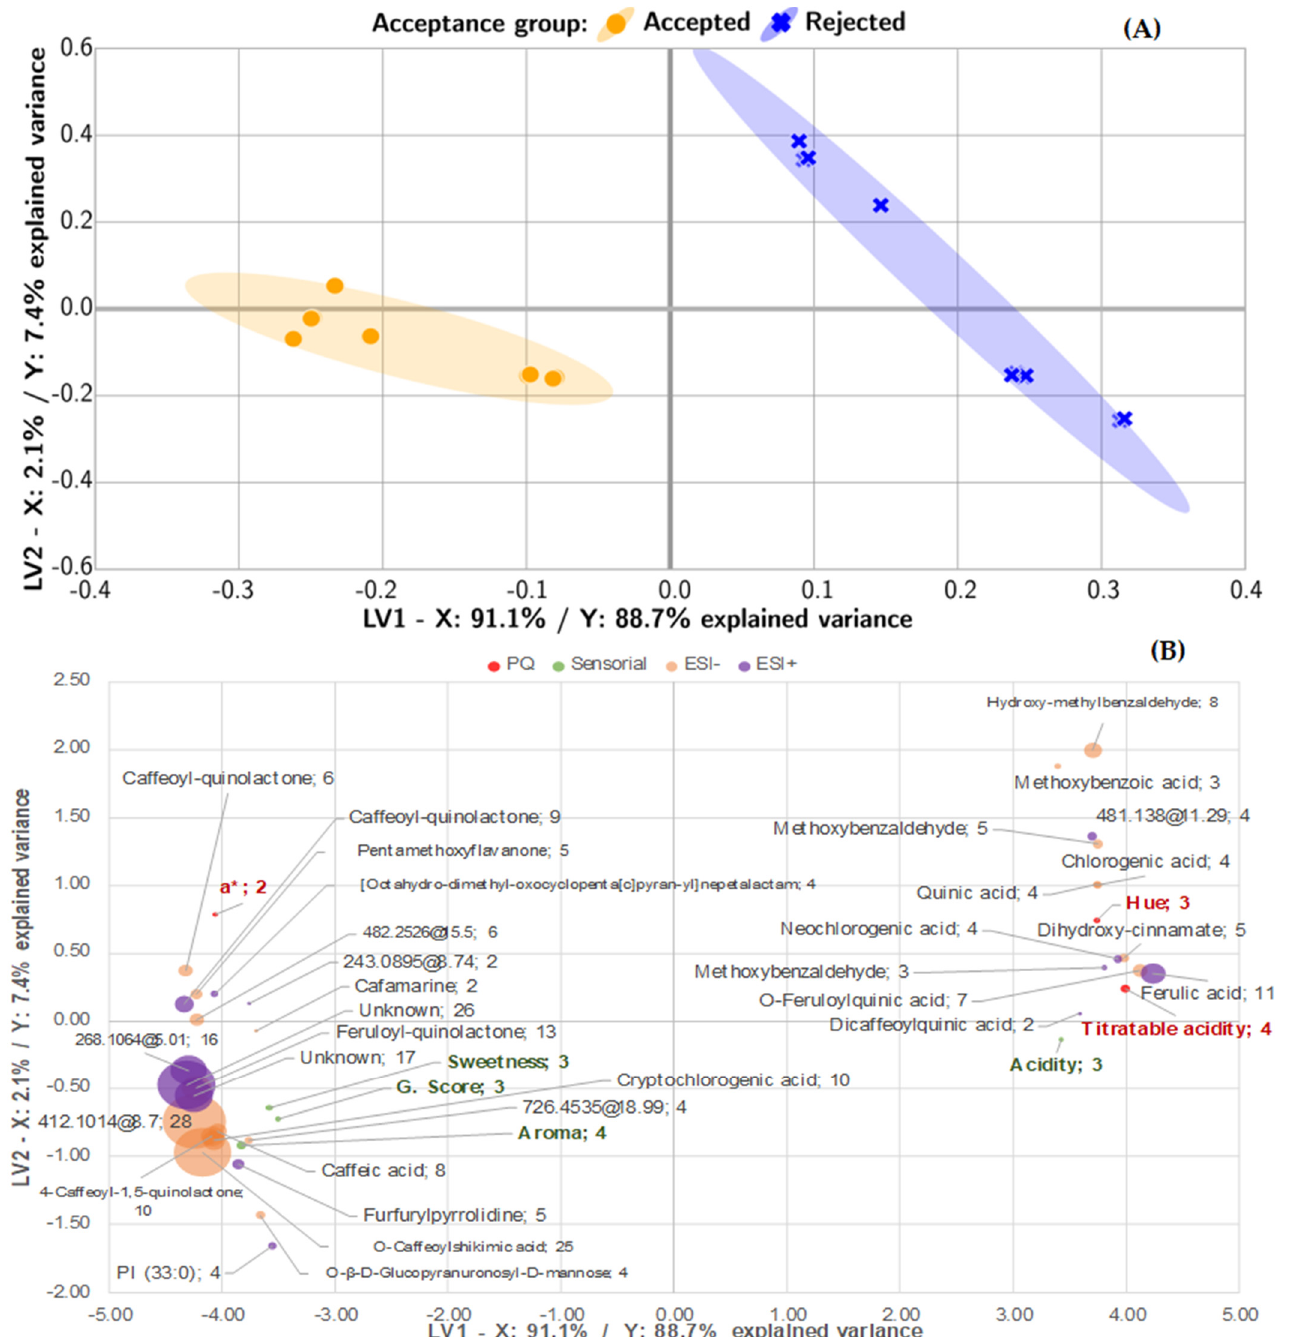
Figure 4. Bootstrapped PLS-DA biplot for acceptance classification. ( A ) Score plot for the averaged PLS-DA model for the first two latent variables, and ( B ) the loadings and selectivity ratio (bubble area) for the physicochemical, sensory, ESI − , and ESI+ datasets for the bootstrapped PLS-DA for acceptance classification.